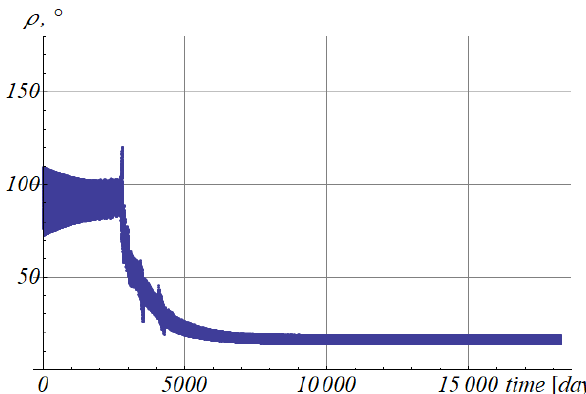
Figure 20. Variation of angle ρ in case of resonance 19:10.